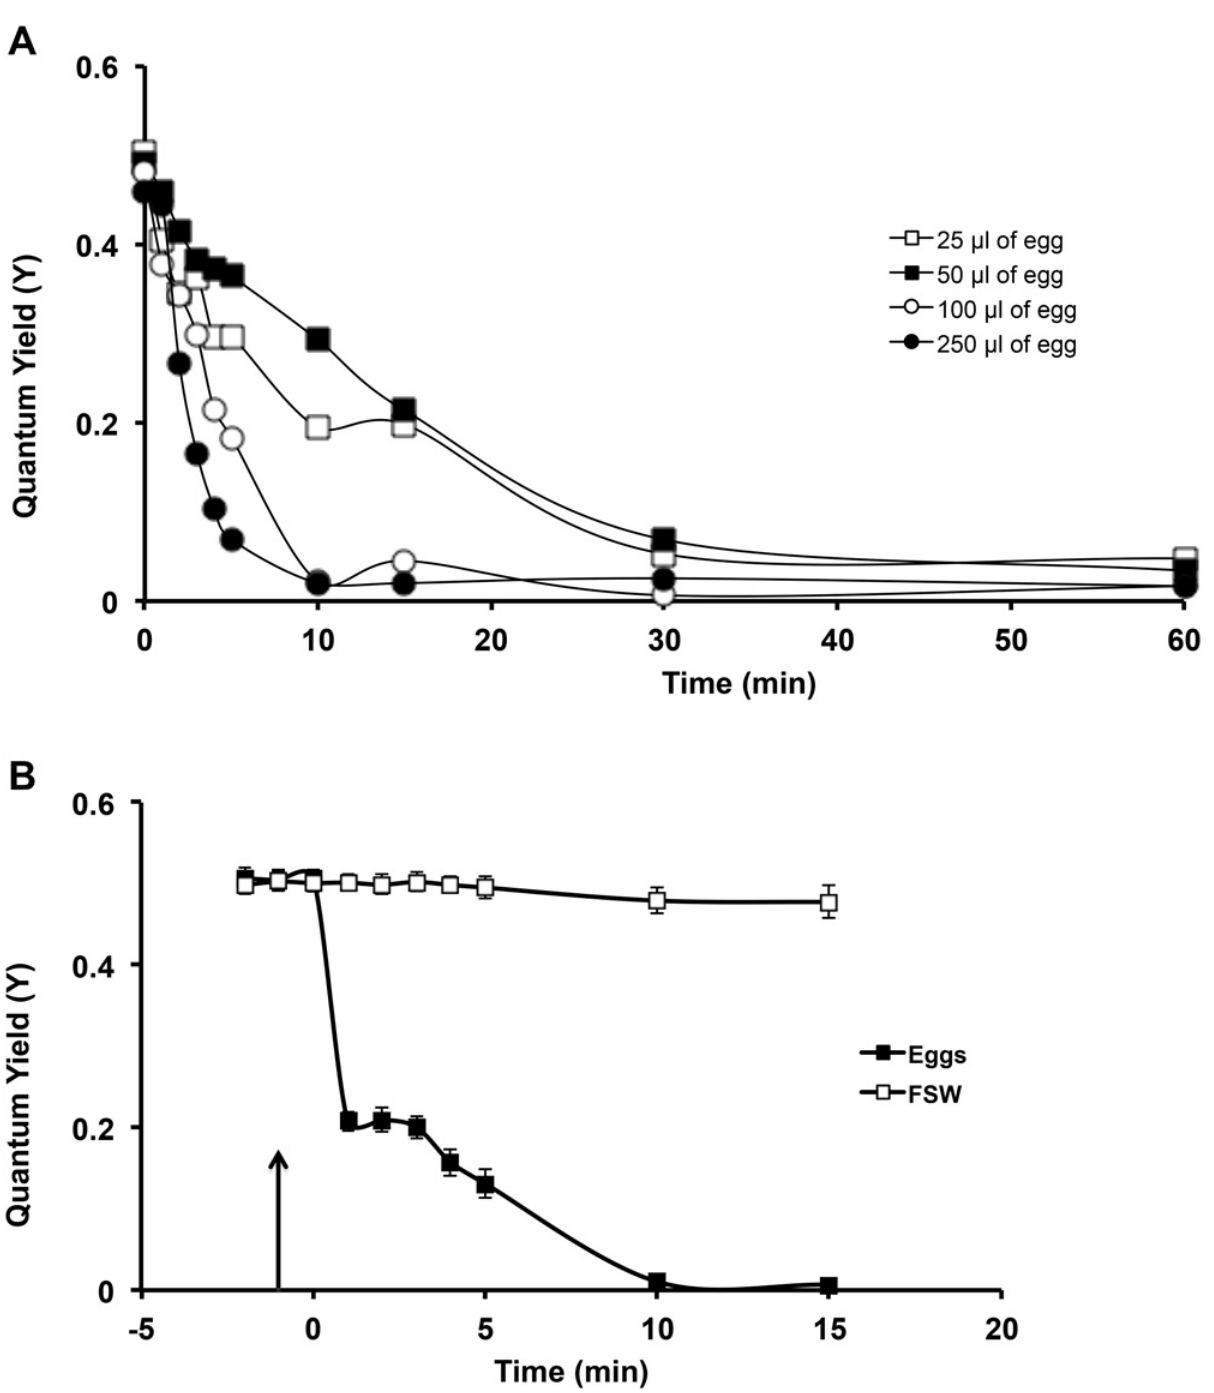
Fig 3. Dose response curve of M . capitata eggs on exogenous zooxanthellae. (A) Preliminary experiments on the dose response curve of the toxins found in M . capitata eggs were conducted against P . compressa zooxanthellae. Both 100 and 250 µ l of egg volume reduced the P . compressa zooxanthellae y-values within 10 min, whereas the smaller volumes took 30 min to do the same. (B) These experiments were repeated with a larger number of P . compressa zooxanthellae samples (n = 10 individuals) split into two sub-samples treated with either 100 µ l of crushed M . capitata (at the 0 min mark indicated by the arrow) or 100 µ l of FSW. Only the M . capitata eggs reduced the Y-values. Bars indicate SEM.